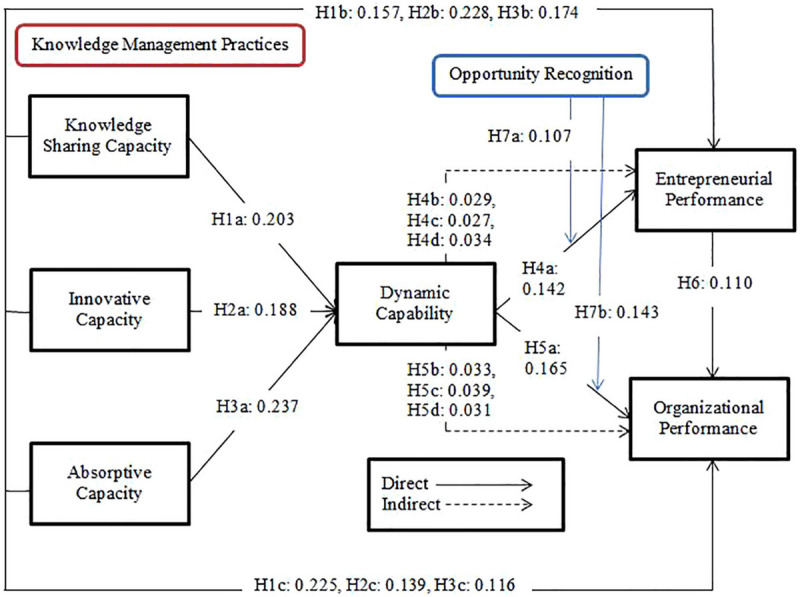
Structural model.